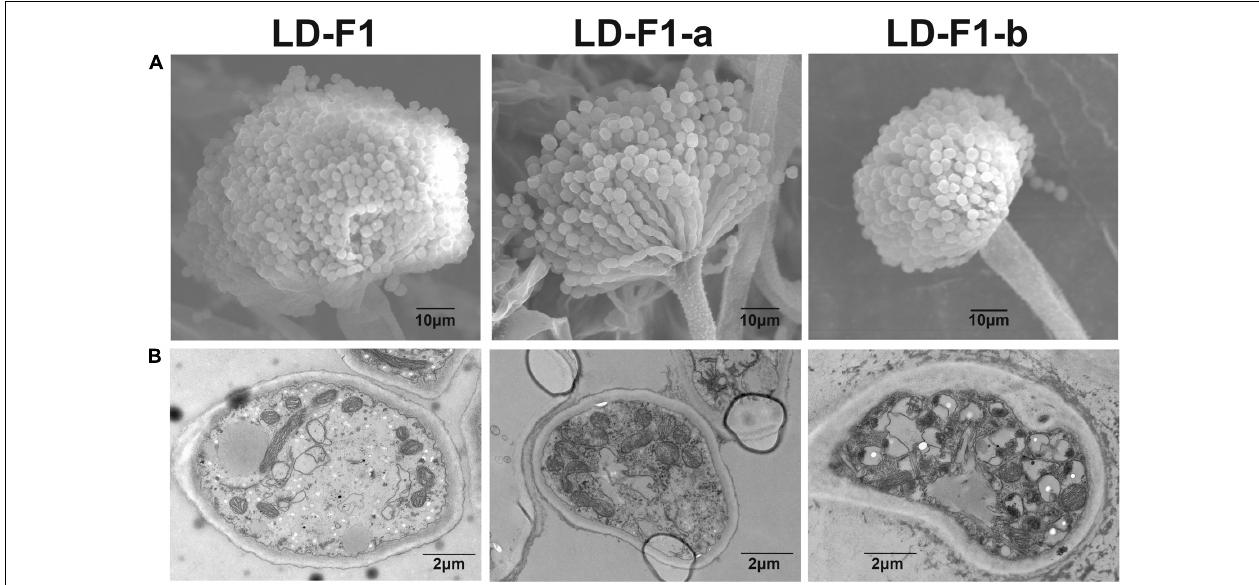
FIGURE 3 | (A) Conidial head of virus-free isolate (LD-F1), AfPV1-infected isolate (LD-F1-b), and AfPV1- and SatRNA-infected isolate (LD-F1-a) were observed by scanning electron microscopy (SEM). (B) Morphology of vacuoles in virus-free isolate (LD-F1), AfPV1-infected isolate (LD-F1-b), and AfPV1- and SatRNA-infected isolate (LD-F1-a) was observed by transmission electron microscope